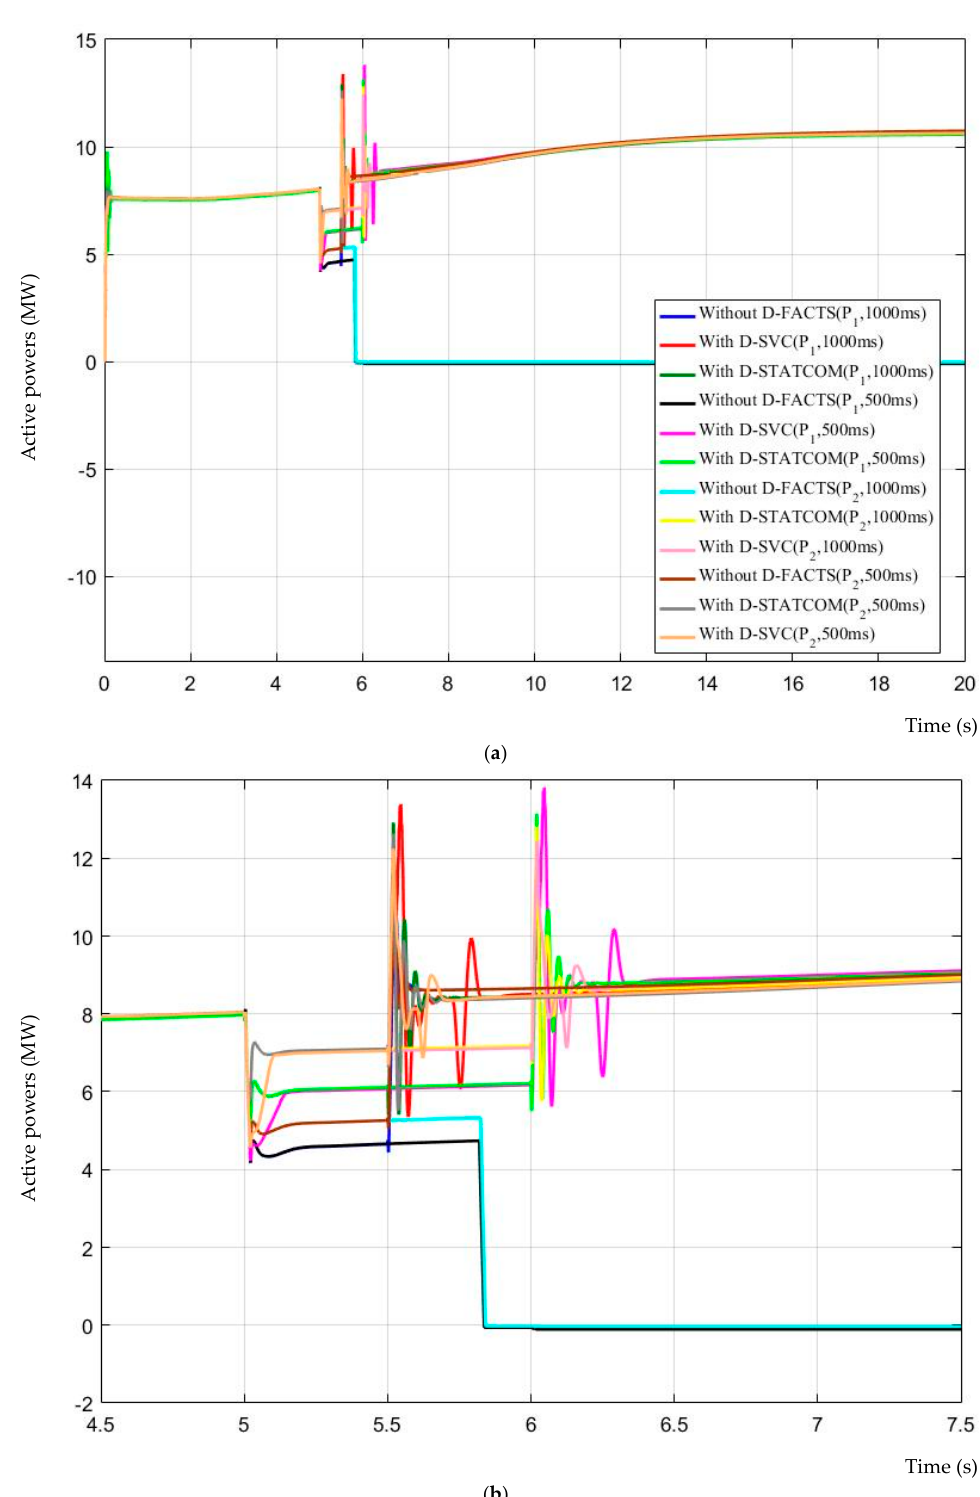
Figure 14. ( a ) Active power at the PCC during line-to-line electrical grid fault; ( b ) zoom of active power at the PCC during line-to-line electrical grid fault.